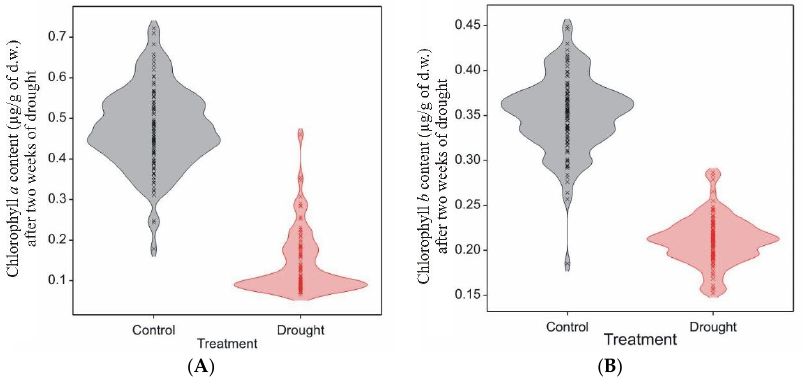
Figure 1. ( A ) The density plot of chlorophyll a content (µg/g of d.w.) after two weeks of drought for treatments. ( B ) The density plot of chlorophyll b content (µg/g of d.w.) after two weeks of drought for treatments.